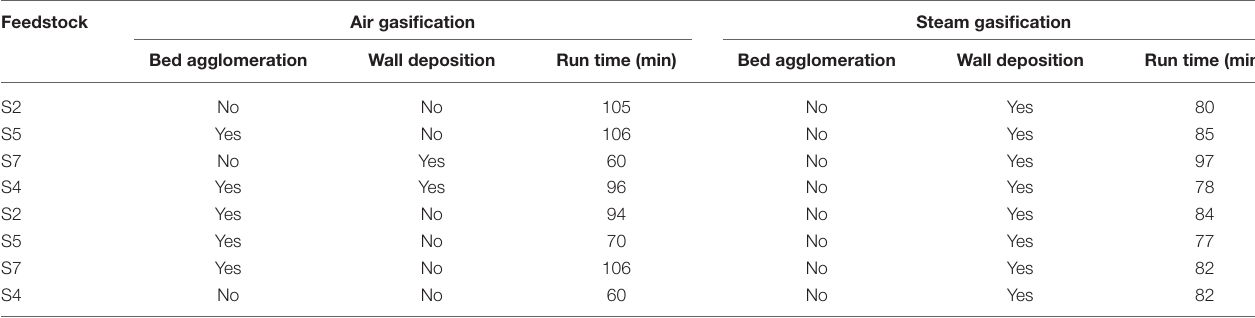
TABLE 7 | Observation of bed agglomeration and wall deposition for air and steam experiments of the four almond feedstocks.